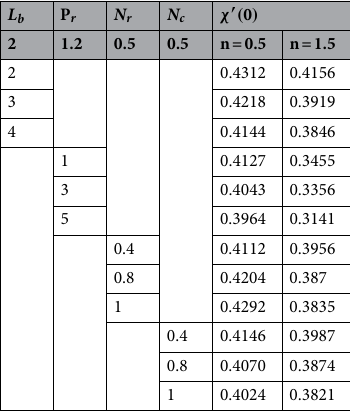
Table 6. Numerical analysis of motile microorganisms χ ′ ( 0 ) for the values of L b